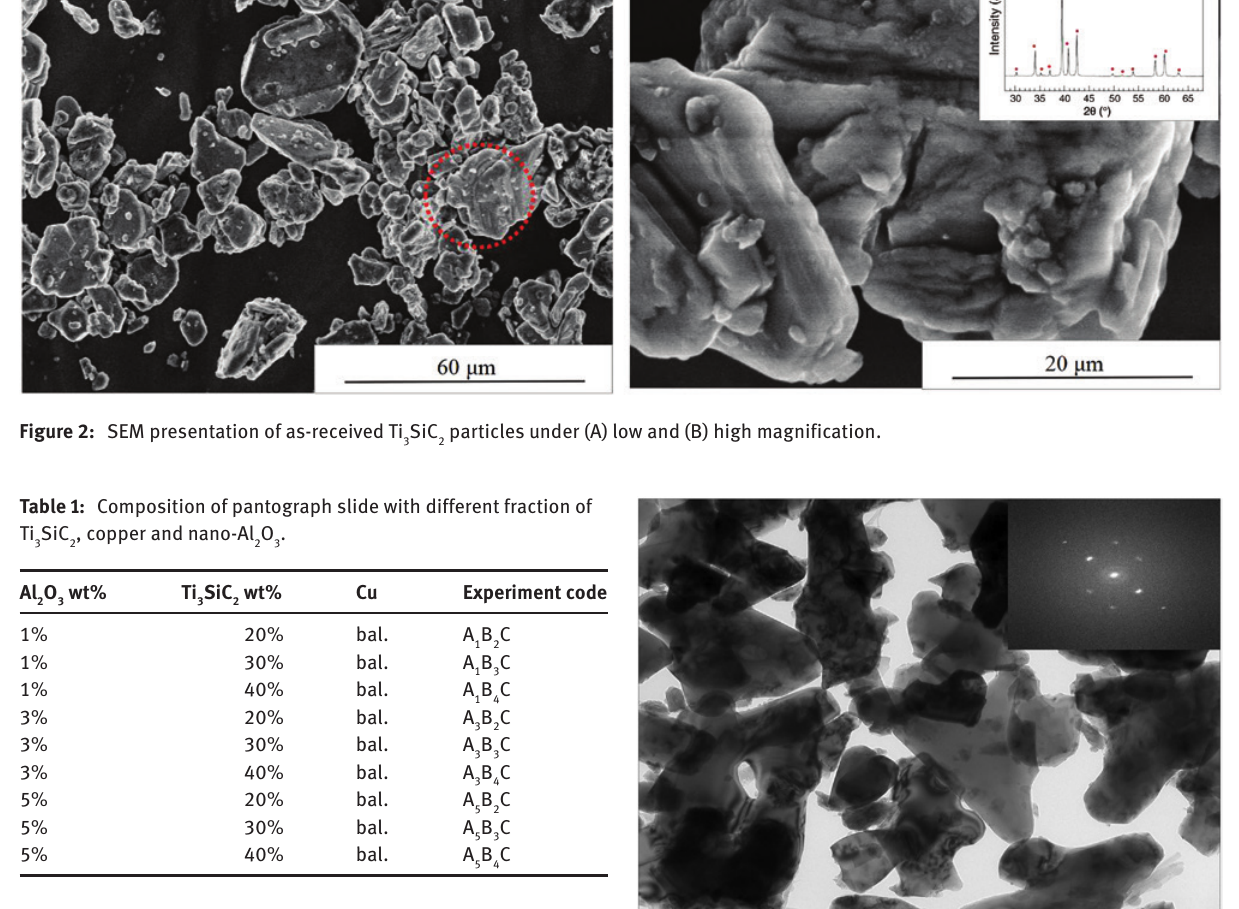
Figure 3: Transmission electron microscopy micrograph of nano- alumina particles after electroless copper